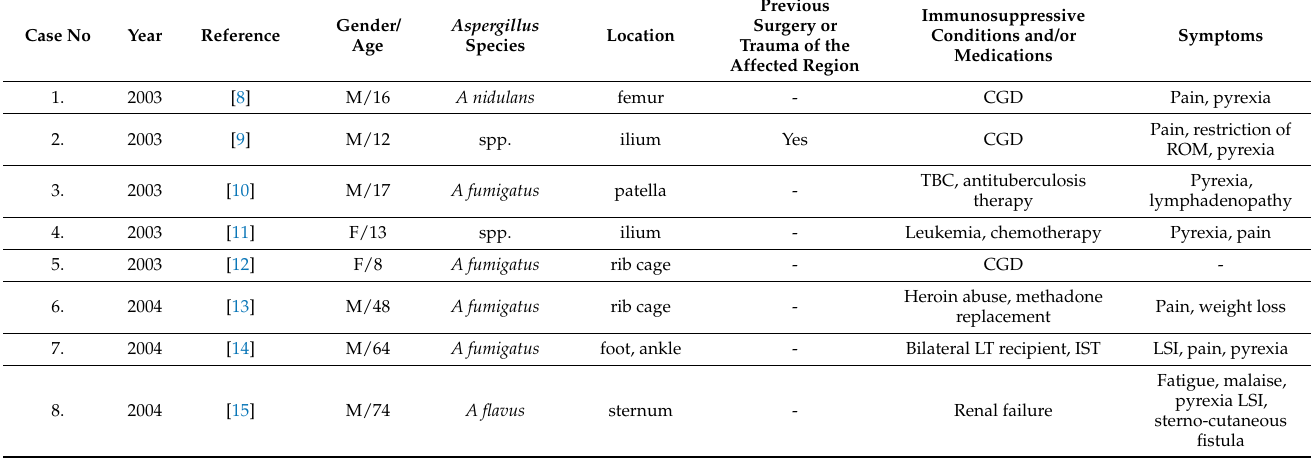
Table 1. Main characteristics of the published osteomyelitis cases due to Aspergillus spp. Year of publication, patient’s demographics, responsible Aspergillus spp., site of infection, immunosuppres- sive condition and/or medications, other site of Aspergillosis, and symptoms. M: male, F: female, CGD: chronic granulomatous disease, TBC: tuberculosis, LT: lung transplant, RT: renal transplant, IST: immunosuppressive treatment, DM: diabetes mellitus, HT: heart transplant, LSI: local signs of